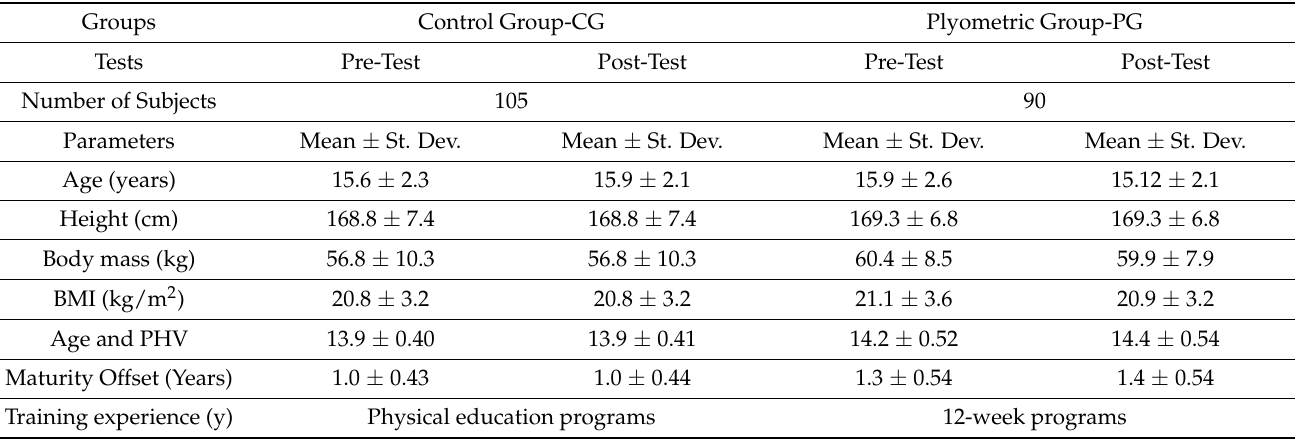
Table 1. Characteristics of the participants (mean ±